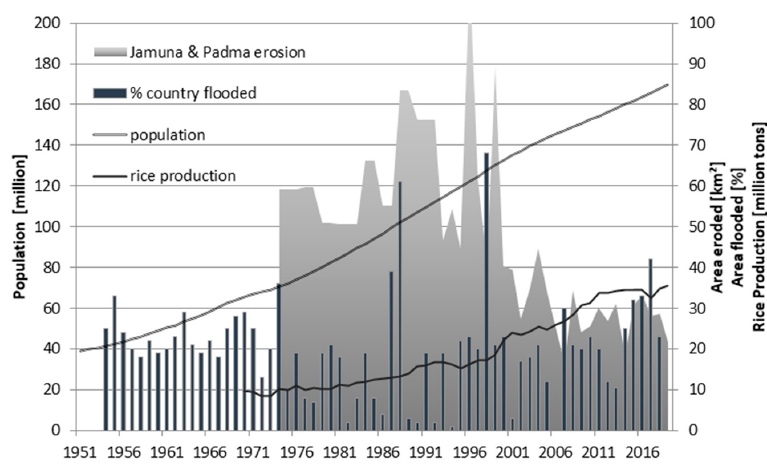
Figure 2. The natural environment of Bangladesh expressed in area flooded (in percentage of Bangladesh) and eroded land along the Jamuna and Padma Rivers (in km 2 ) compared with the population growth and annual rice production (in million metric tons) (data source: CEGIS).